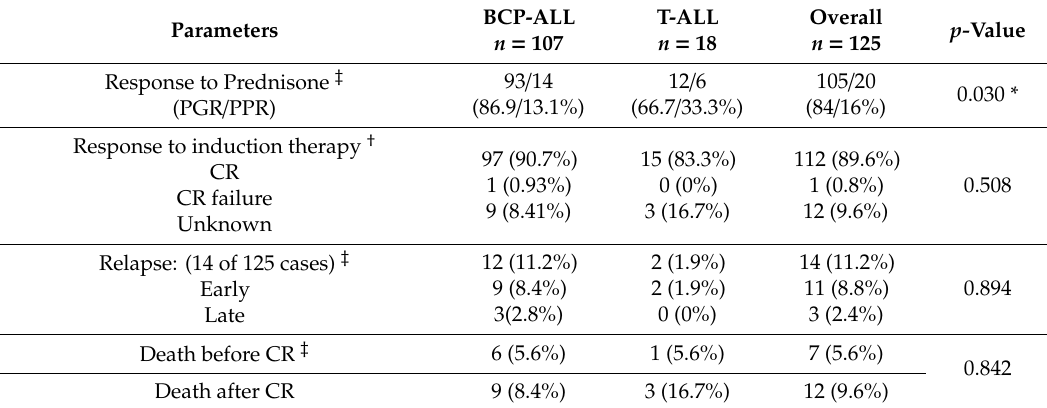
Table 5. Response to chemotherapy, relapse, and outcome. Univariate